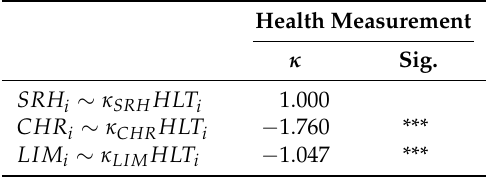
Table 5. Results for the measurement of health (Equation